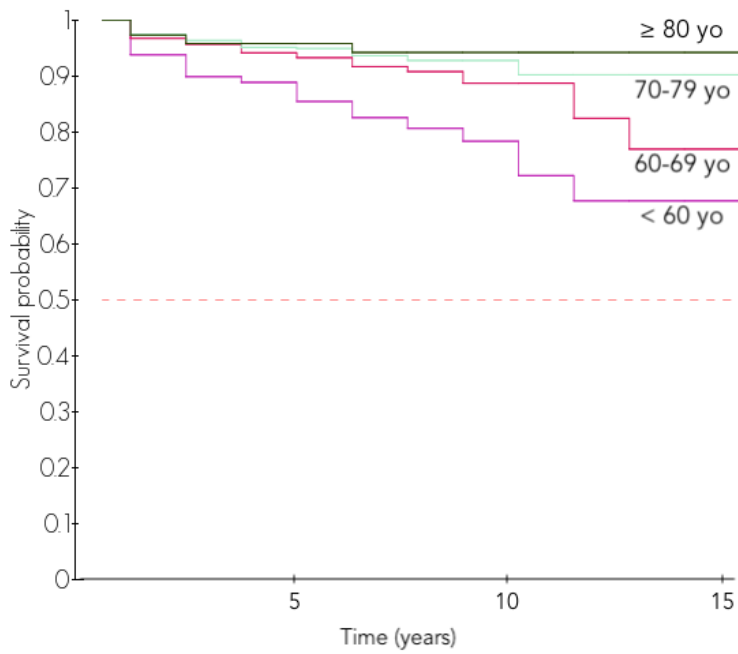
Figure 3. Revision-free survival of 239 revision RSA according to gender. A younger age at surgery was associated with higher rates of complications and revisions: patients younger than 60 years at the time of RSA had a 10-year survival of 75.7% while patients between 60 and 69, 70 and 79 and over 80 years had a 10-year survival of 88.8%, 91.3% and 94.3% respectively ( p < 0.001, Table 4, Figure 4).